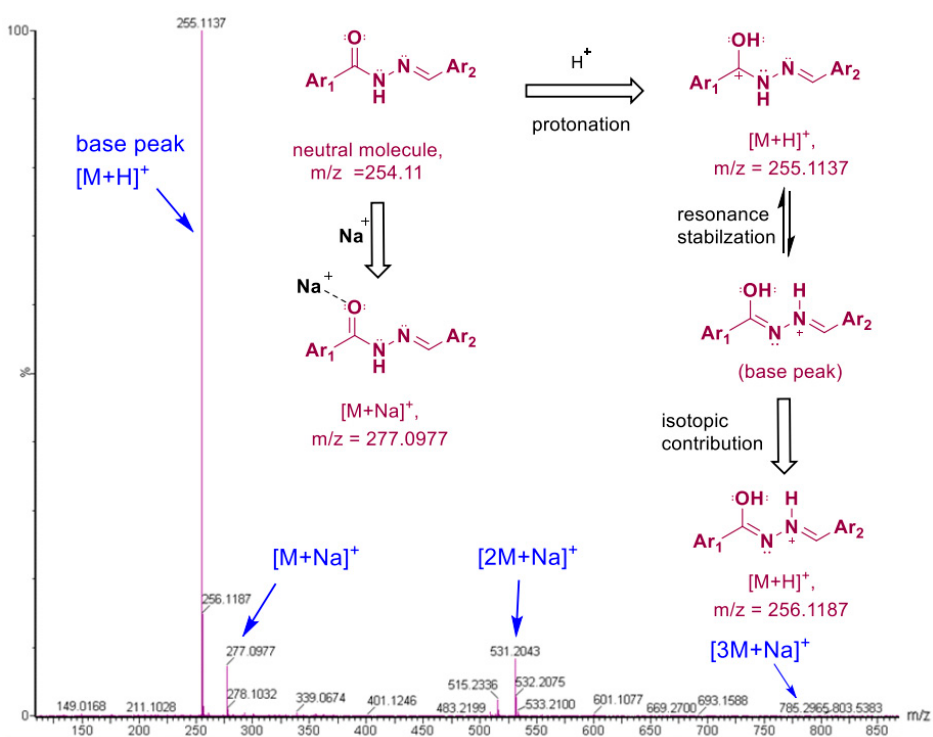
Figure 4. Mass spectrum (ES+ mode) of N ′ -(4-methoxybenzylidene)benzohydrazide (HL) Schiff base and its suggested fragmentation pathways.